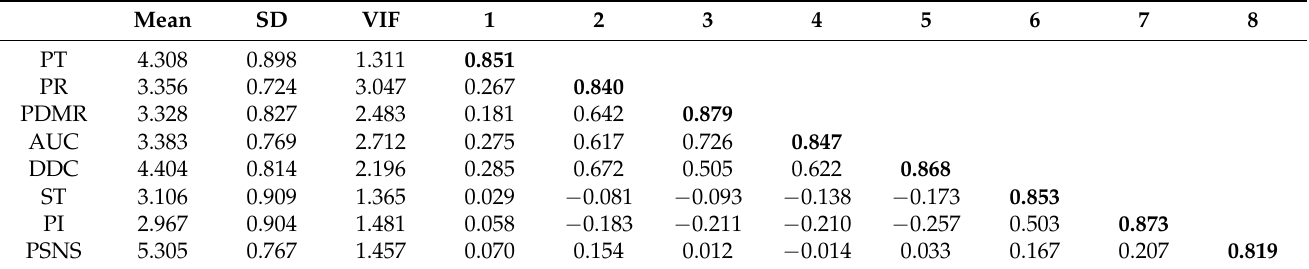
Table 3. Descriptive statistics and evidence of discriminant